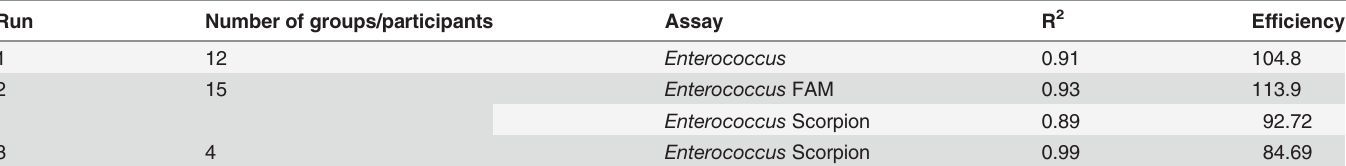
Table 2. Summary of standard curve qPCR results as a progression during the workshop.